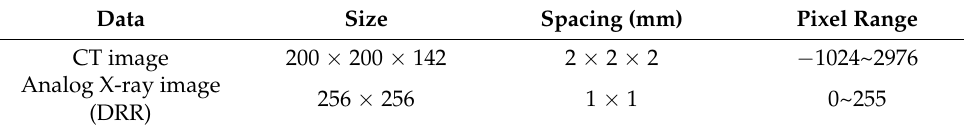
Table 1. Related parameters of image